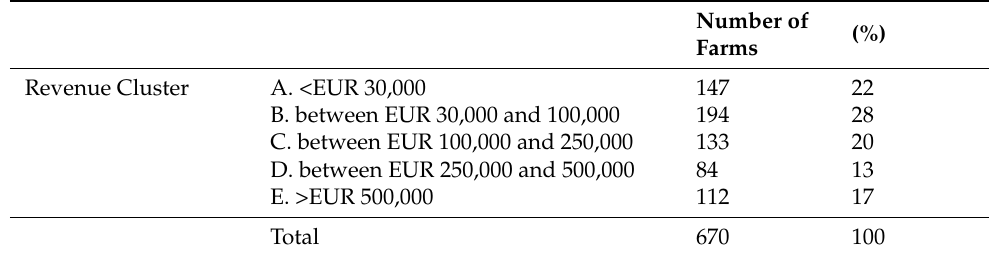
Table 4. Revenue clusters distribution in the sample.